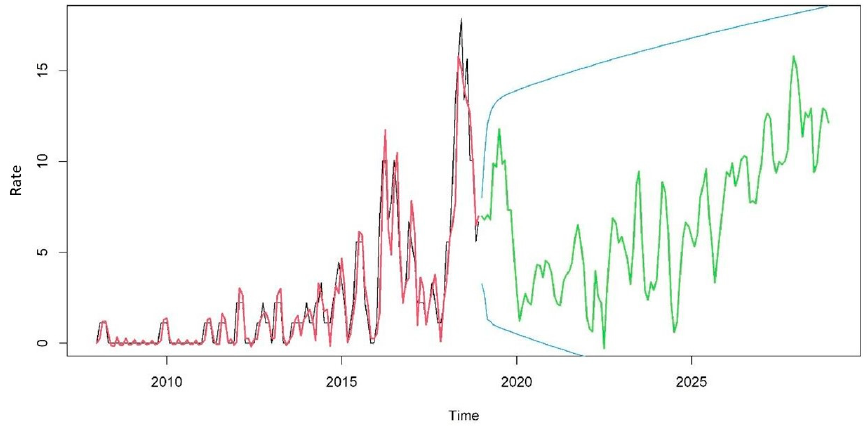
Figure 3. TBDR trend from 2018 to 2028 in the state of Paraná, Brazil.